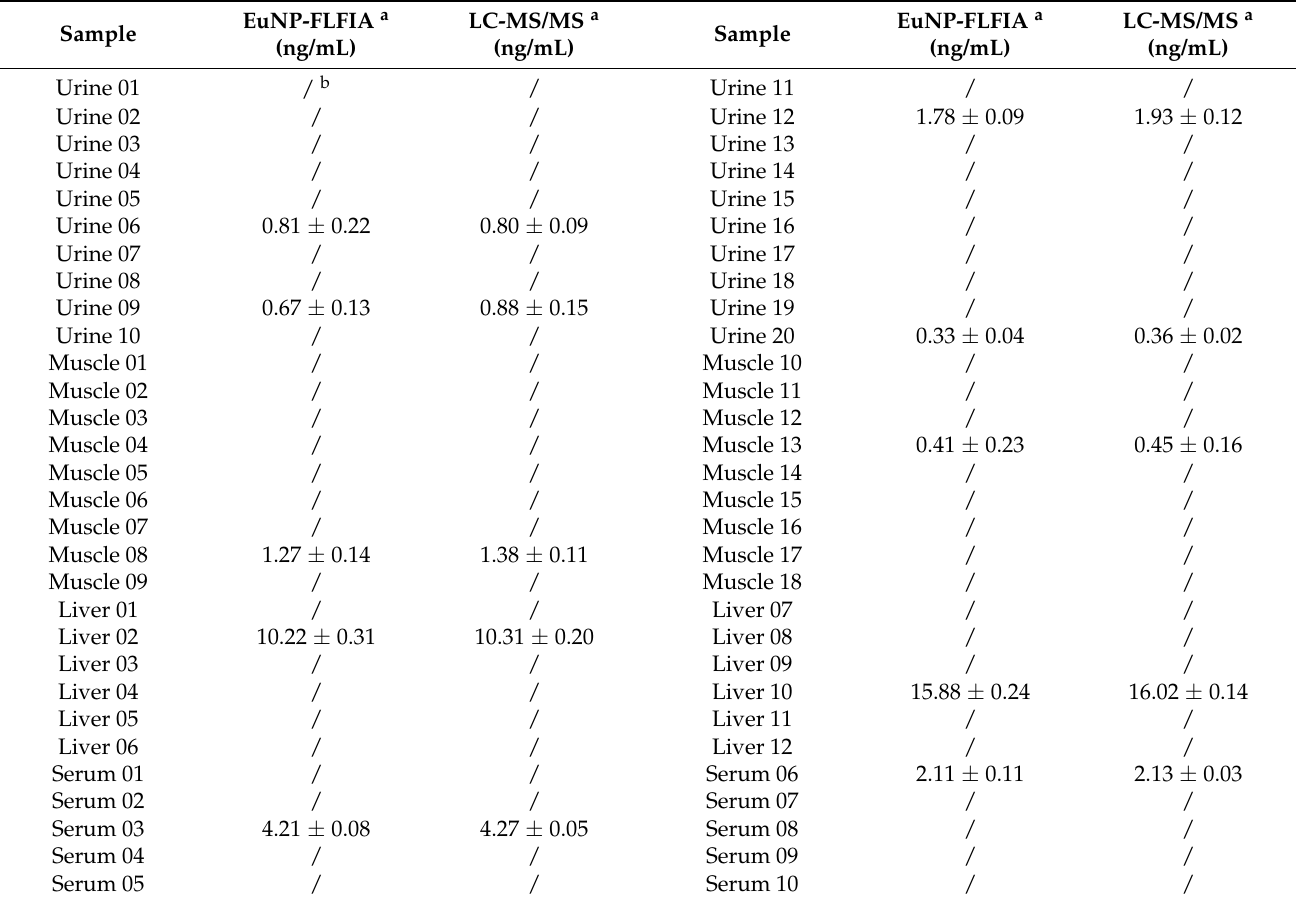
Table 3. Detection of β 2 -agonists in actual samples from EuNP-FLFIA with LC-MS/MS.